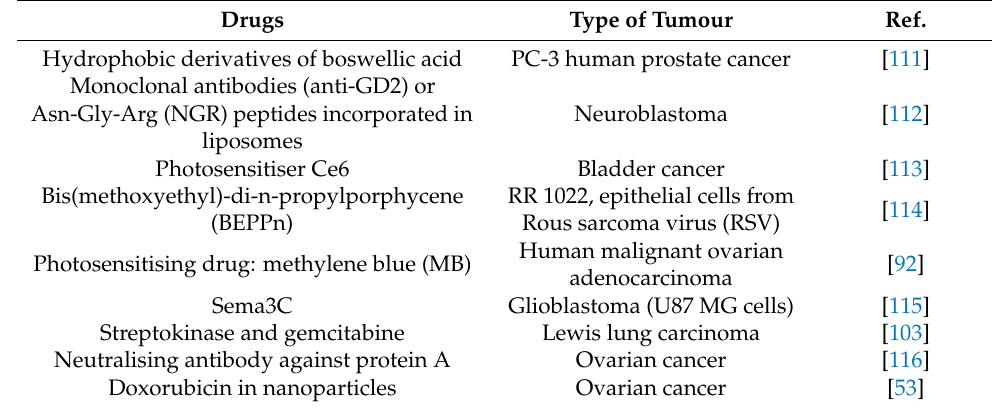
Table 5. Drug assays for tumour grafts or metastasis on a CAM